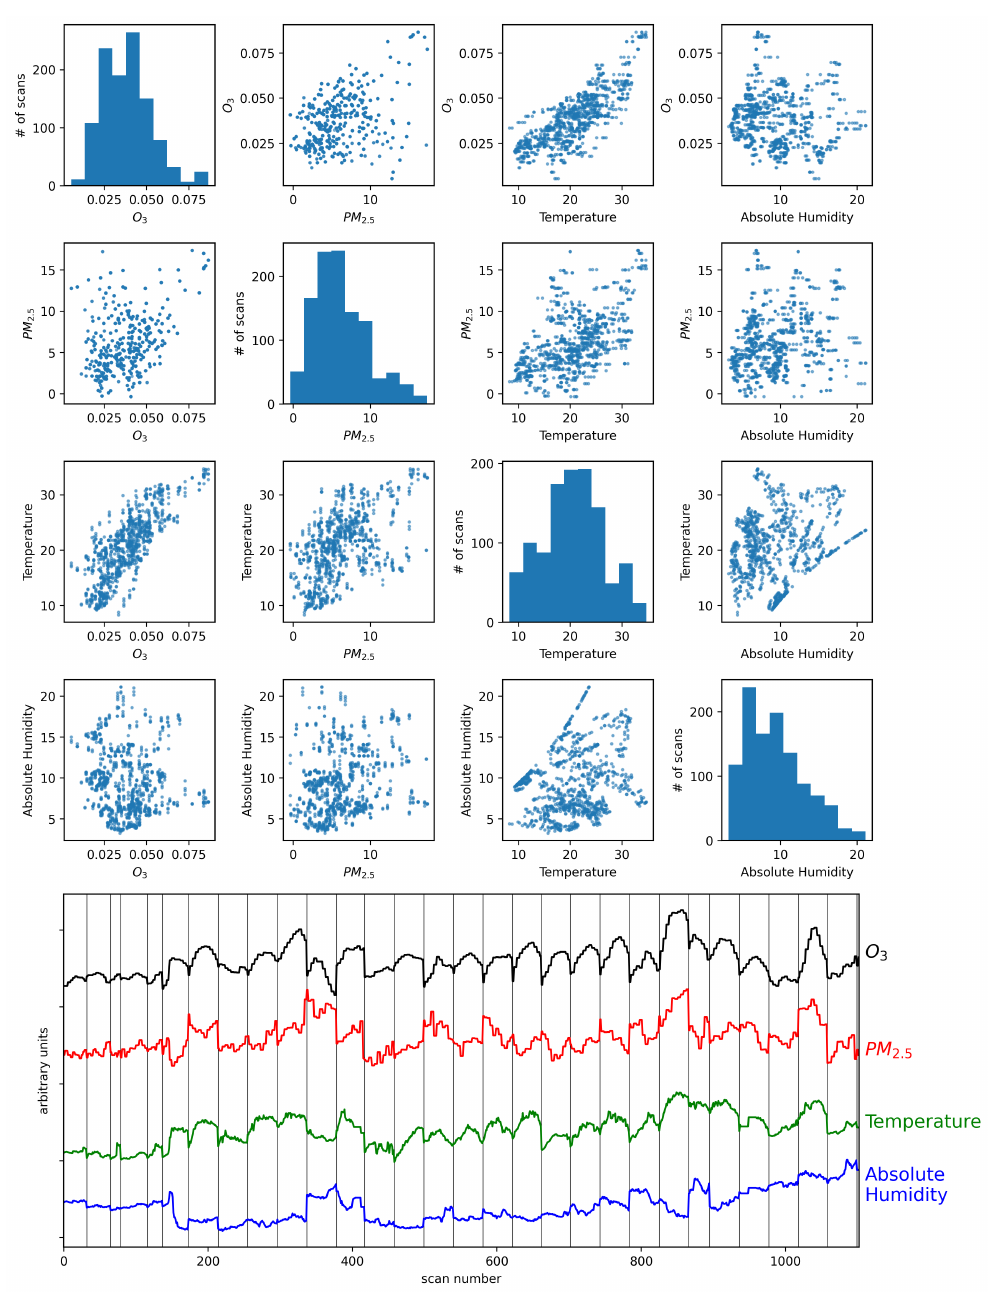
Figure 5. ( Top ): Air quality scatter matrix showing the distribution of O 3 (in ppm) and PM 2.5 (in µ g/m 3 ) concentrations, temperature (in ◦ C), and absolute humidity (in g/cm 3 ). ( Bottom ): Normal- ized and offset O 3 and PM 2.5 concentrations, temperature, and absolute humidity as a function of scan number. Vertical lines indicate the change in